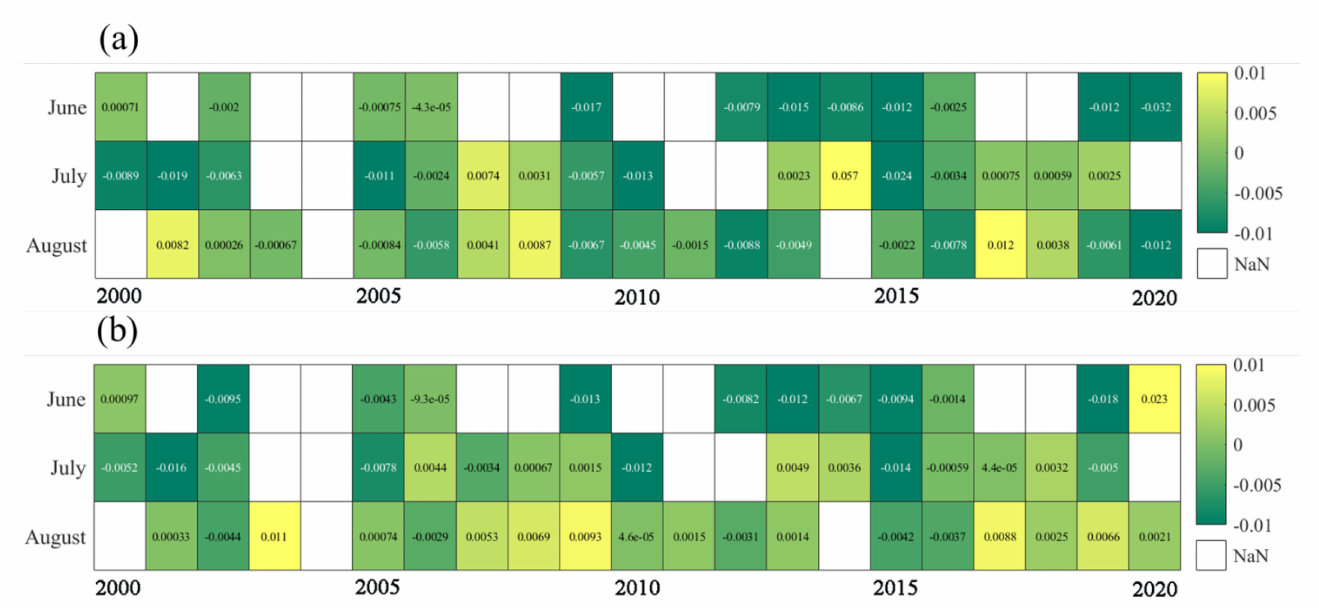
Figure 5. Matrix heatmap of the ∆ VGR from June to August on the Tibetan Plateau from 2000 to 2020. The matrix heatmap ( a ) refers to the ∆ VGR calculated from NDVI; the matrix heatmap ( b ) refers to the ∆ VGR calculated from EVI. Each grid cell represents the average vegetation growth rate anomaly at all sites in a given month of a year. The blank grid cell represents no heatwave happened, and the value is NaN. The color of the matrix heatmap represents the size of the value.